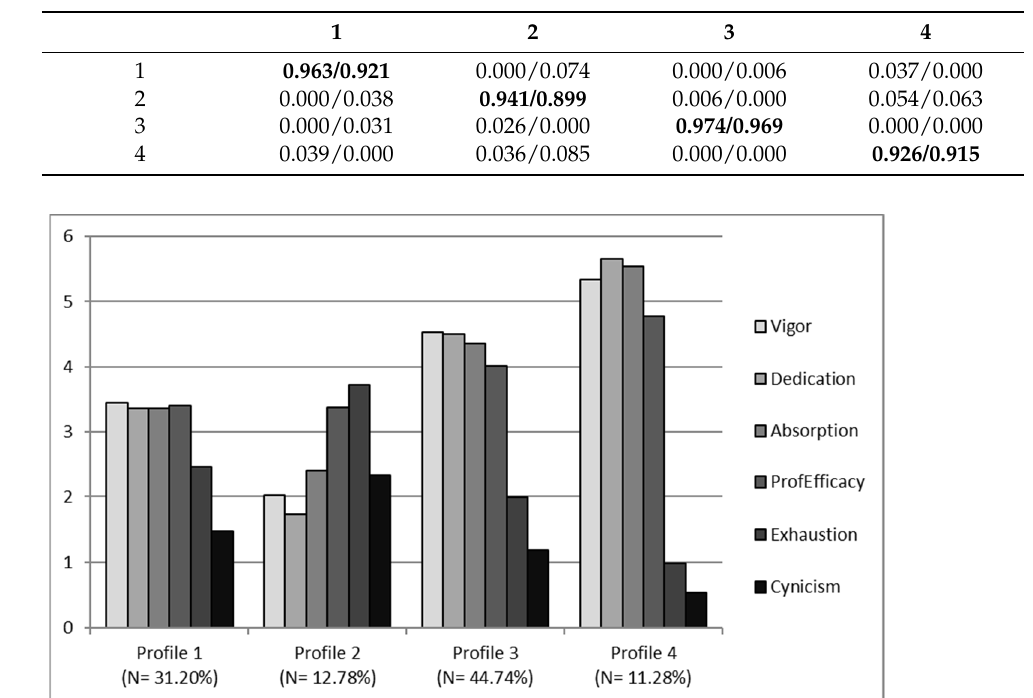
Figure 2. Profile distribution in TRAS.